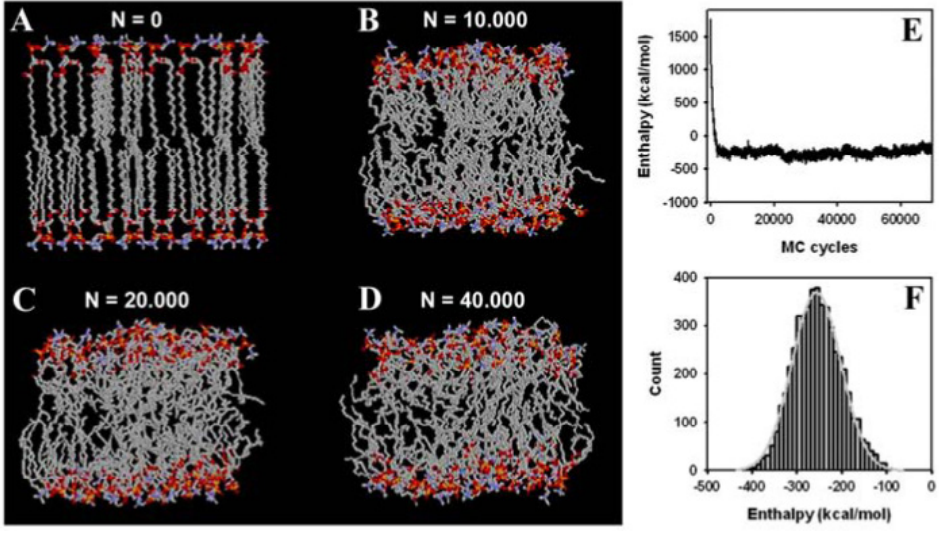
Figure 5. Simulation snapshot and system energy of a DPPC bilayer. The membrane simulation started from a crystalline bilayer consisting of 32 DPPC molecules with straight fatty acyl chains in each leaflet. Each molecule was rotated by a random rotation angle around the molecular long axis in the start configuration (( A ), “ N = 0”); ( B – D ) show snapshots after N = 10,000 ( B ); N = 20,000 ( C ); and N = 40,000 ( D ) MC steps, respectively. United atoms of methyl and methylen as well as carbon atoms are shown in grey, oxygen in red, nitrogen in blue, and phosphorus in yellow. Fatty acyl chains become increasingly disordered in course of the simulation; ( E ) the enthalpy of the bilayer in the implicit solvent was calculated after a given number of MC steps of the simulation performed in the constant NPT -ensemble. The temperature of the simulation was 323 K ( i.e. , 50 °C); ( F ) a histogram of the conformational energy of the last 40,000 MC steps (grey bars) overlaid with a fit to a Gaussian function of the form ( ) provides the mean energy at equilibrium, E , and the 2 )2)((exp)( σ⋅−⋅= EEAEf standard deviation, σ , as a measure of fluctuations around the mean value (light grey line). See text for further explanation.